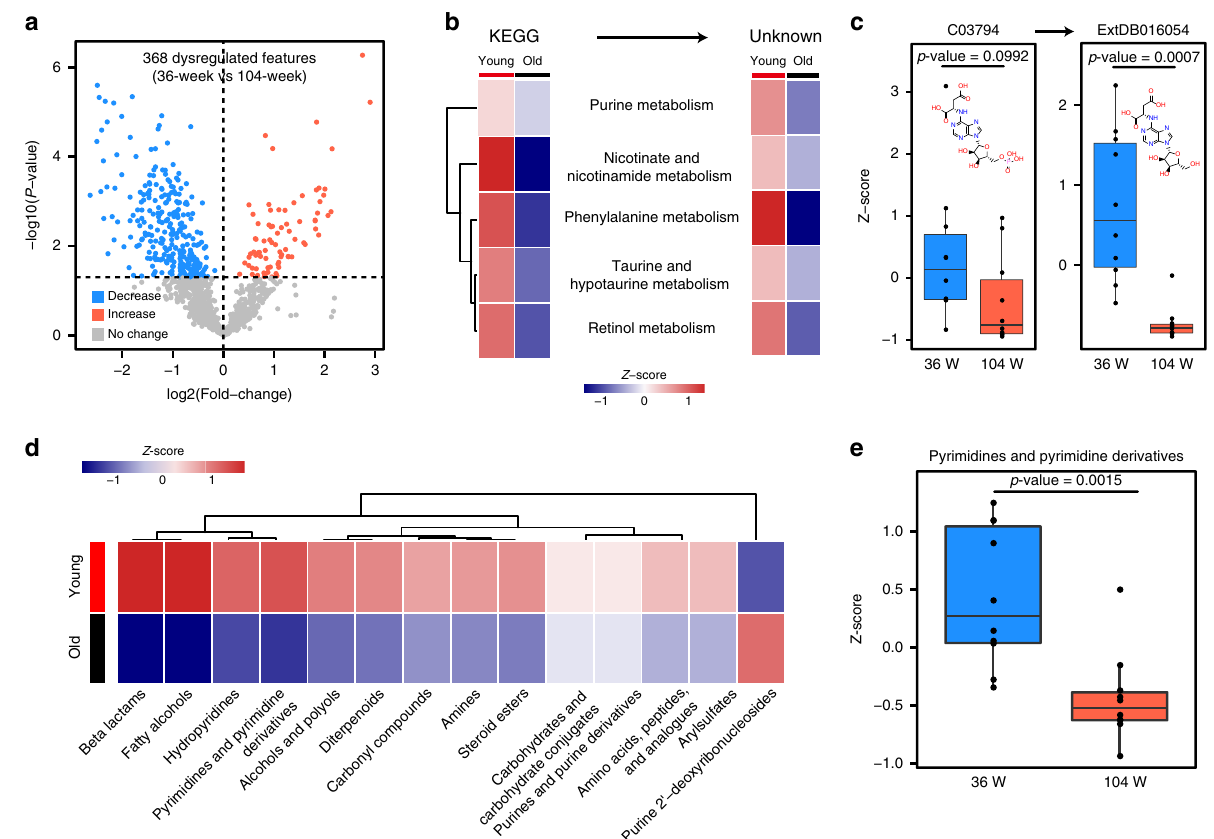
Fig. 6 Expansion of metabolite coverage and assessment of metabolic activities with unknown annotation. a Volcano plot showing the dysregulated features in aging mice (36-week vs. 104-week; p -value ≤ 0.05; two-sided Student ’ s t -test); b heat maps showing age-dependent activities of fi ve enriched KEGG metabolic pathways (left panel) and their related unknowns (right panel); c examples of adenylosuccinic acid and its derived unknown (ExtDB016054) down-regulated in aging mice ( n = 10, biologically independent samples for each group; two-sided Student ’ s t -test); d heat map showing age-dependent activities of 14 enriched chemical subclasses; e annotated unknowns from the subclass of pyrimidines and pyrimidine derivatives down- regulated in aging mice ( n = 10, biologically independent samples for each group; two-sided Student ’ s t -test). The lower, middle, and upper lines in box plots ( c , e ) correspond to 25th, 50th, and 75th quartiles, and the whiskers extend to the most extreme data point within 1.5 interquartile range (IQR). Source data are provided as a Source Data fi